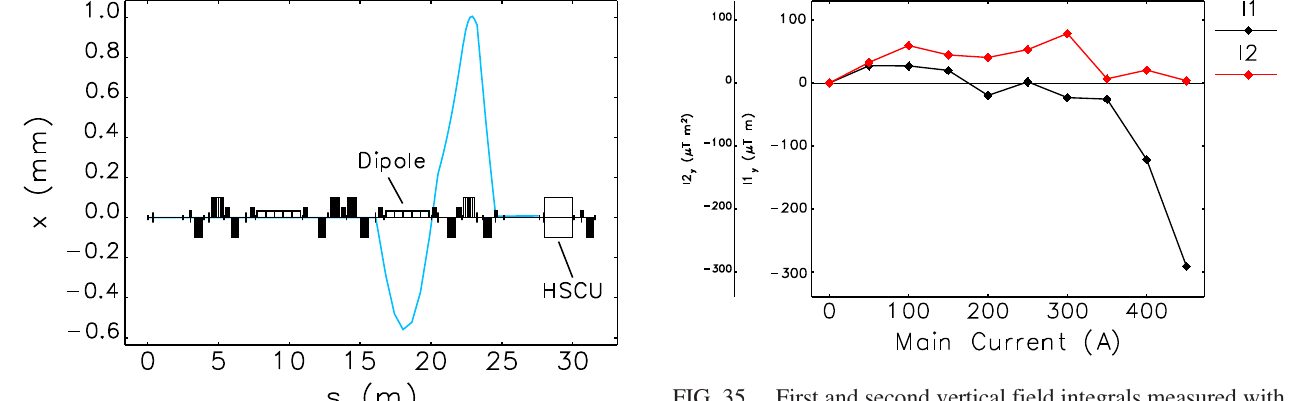
FIG. 35. First and second vertical field integrals measured with the beam with internal correctors running but without external